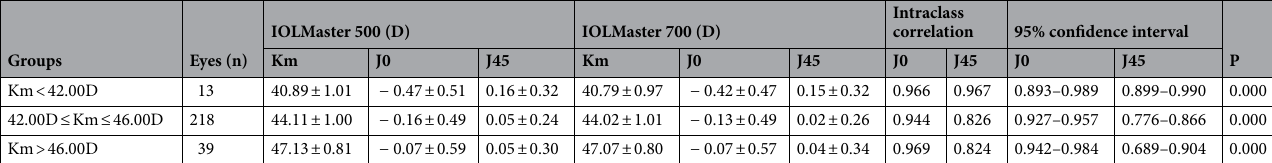
Table 3. The subgroup analysis of Km measurement and the ICC analysis.